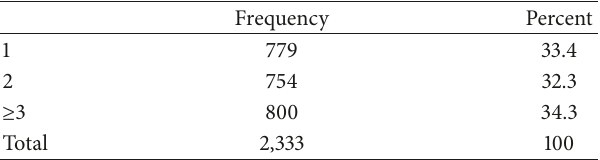
Table 1: Demographic data. Table 2: Sentinel lymph nodes obtained.